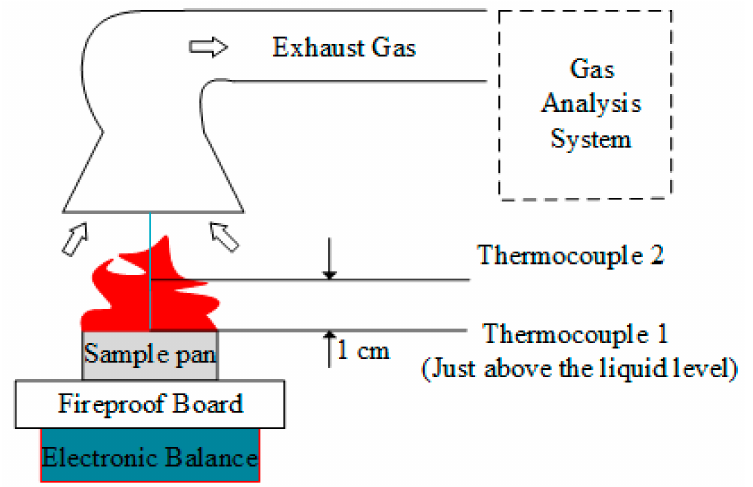
Figure 1. Structure diagram of the combustion platform including a cone calorimeter, with two ther- mocouples in Hefei (100.09